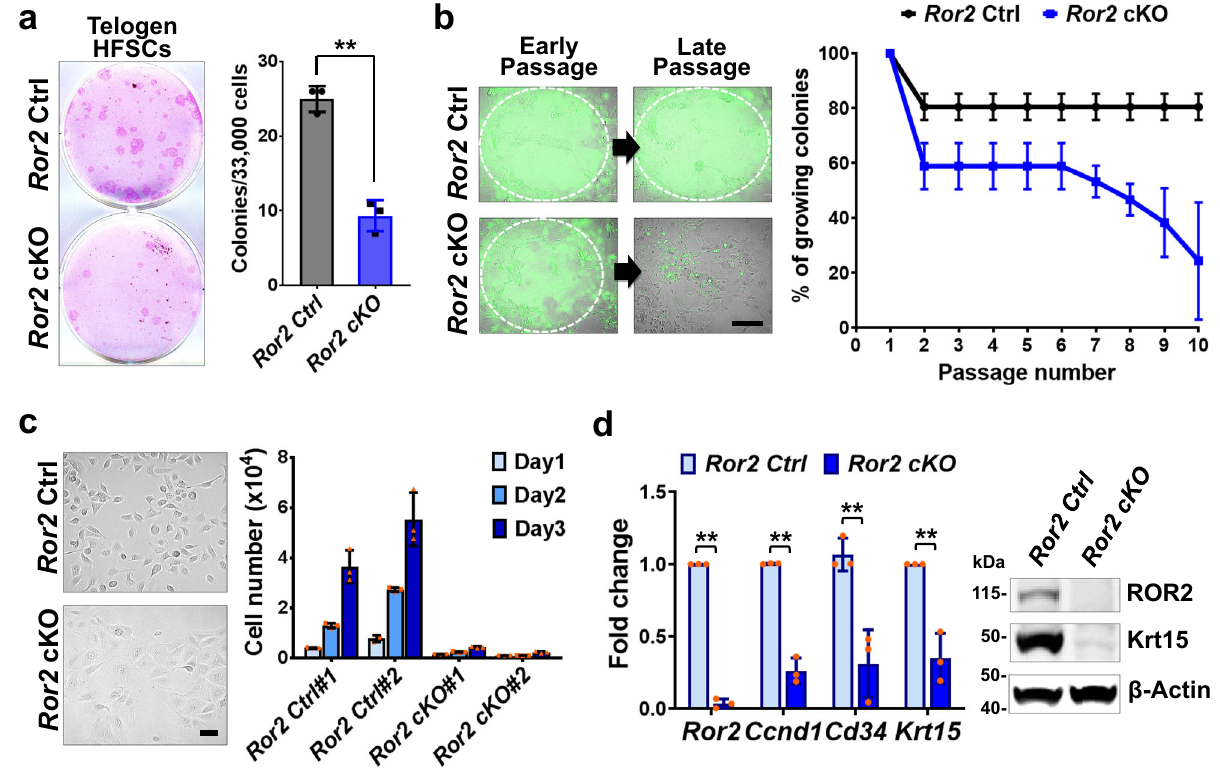
Fig. 3 | ROR2 is required for HFSC self-renewal and long-term maintenance. a CFE of Ror2 Ctrl and cKO HFSCs from telogen-phase back skins. Colonies from FACS-puri fi ed HFSCs are stained with Rhodamine B (left). Quanti fi cation of CFE (right). Numbers of colonies which sizes ≥ 3 mm 2 were counted. Data are reported as average ± s.d.; n =3 independent wells; ** p =0.0007. Results are representative ofatleasttwoindependentexperiments. b Ror2 cKOHFSCscouldnotbepassaged and maintained for long-term. Individual Ror2 Ctrl or cKO HFSC colonies were isolated,culturedandpassaged. Ror2 depletionwasveri fi edforindividualcolonies. (Left) Ror2 CtrlHFSCscouldbepassagedandmaintainedwithfeedersasevidenced by YFP expression, whereas YFP+ Ror2 cKO HFSCs got lost along passaging. White dashed lines denote the outline of HFSC colonies. Scale bar represents 200 μ m. (Right)Plotgraphshowingthat Ror2 cKOHFSCscouldnotbelong-termmaintained